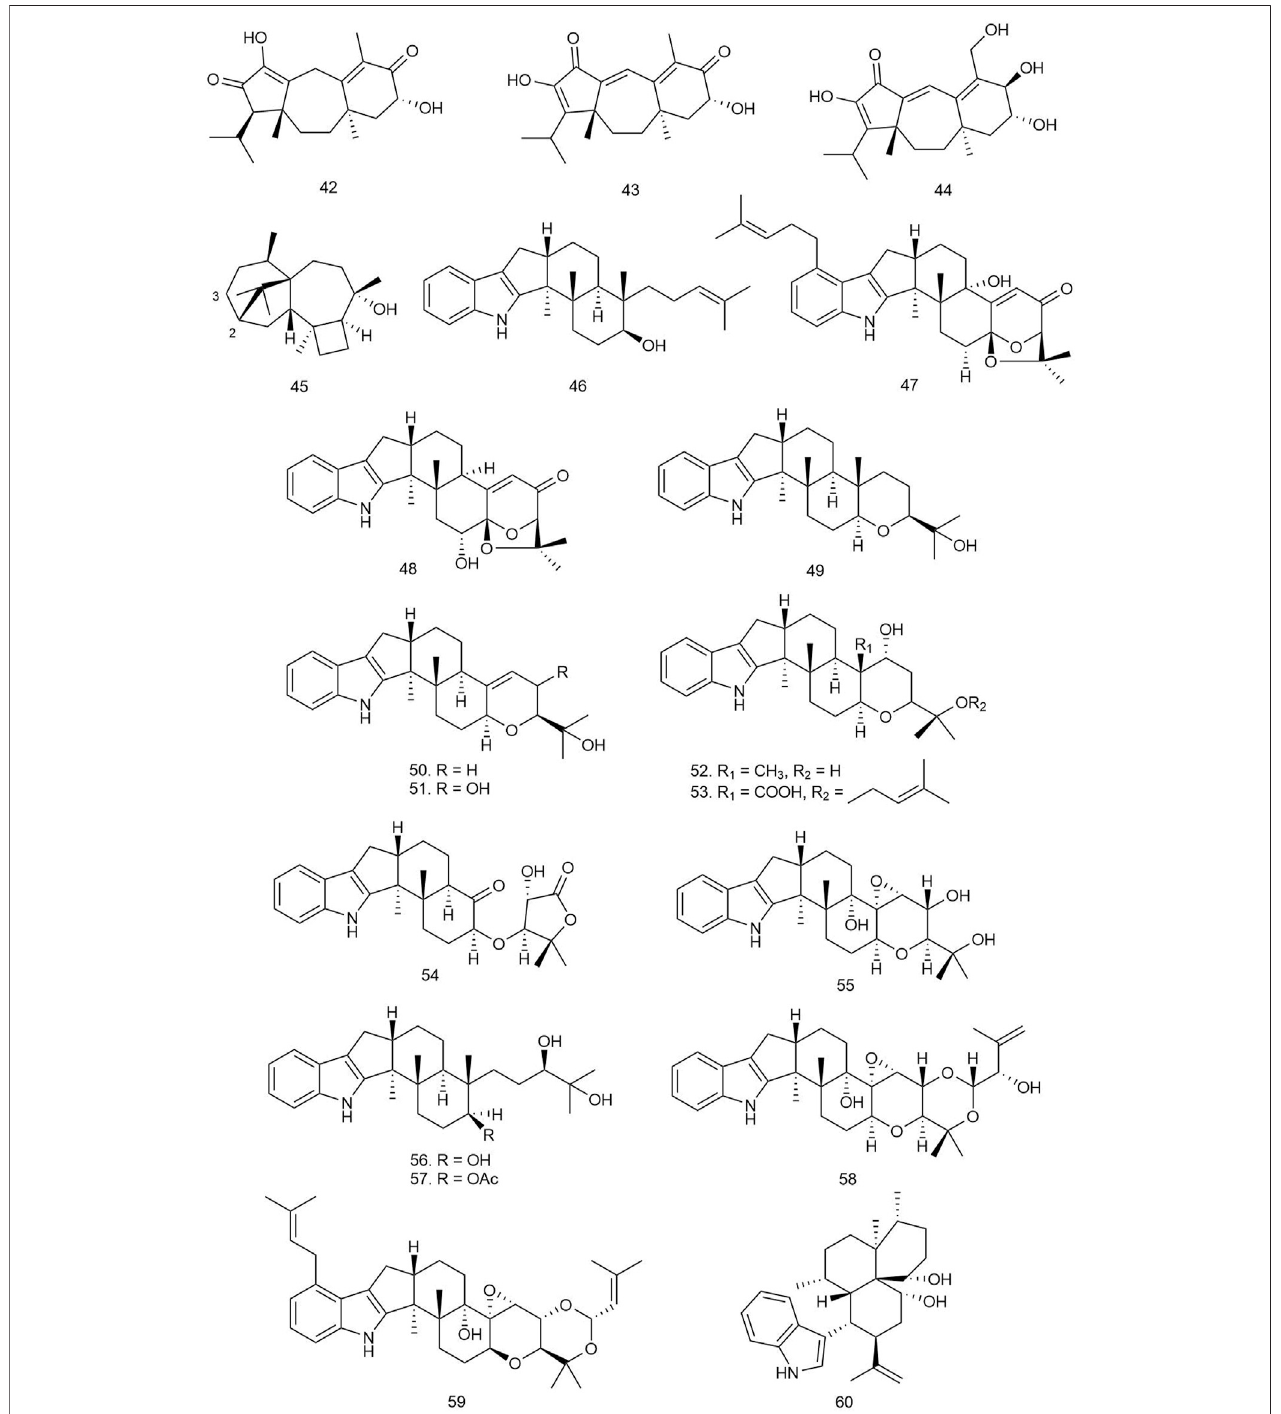
FIGURE 4 | Structures of guanacastane, harziane, and indole diterpenoids with signi fi cant antibacterial activity.